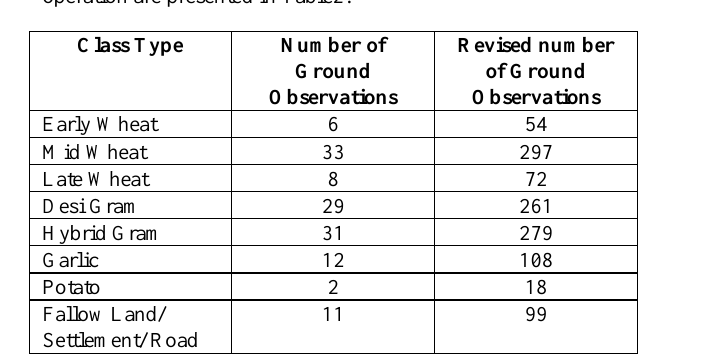
Table 2. Ground Truth data of the study area